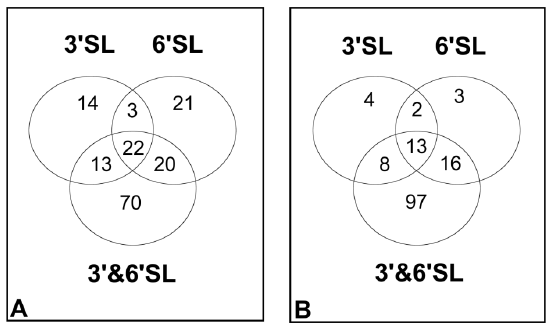
Figure 4. Effects of trypsin treatment on adhesion of B.longum subsp. infantis ATCC 15697 to HT-29 cells following exposure to 6 9 sialyllactose (1 mg/ml, 3 hours). Results are expressed as fold- change in percent adhesion in relation to the control with error bars representing standard deviation. a denotes significance in relation to the control, p , 0.05; b denotes significance in relation to Trypsin control and